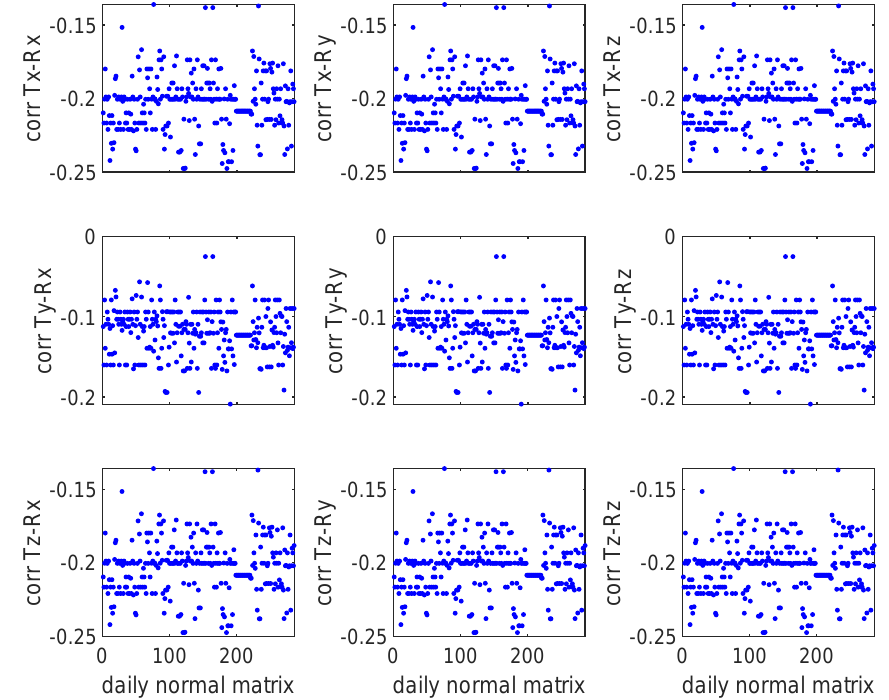
Figure 5. Correlation between translation and rotation